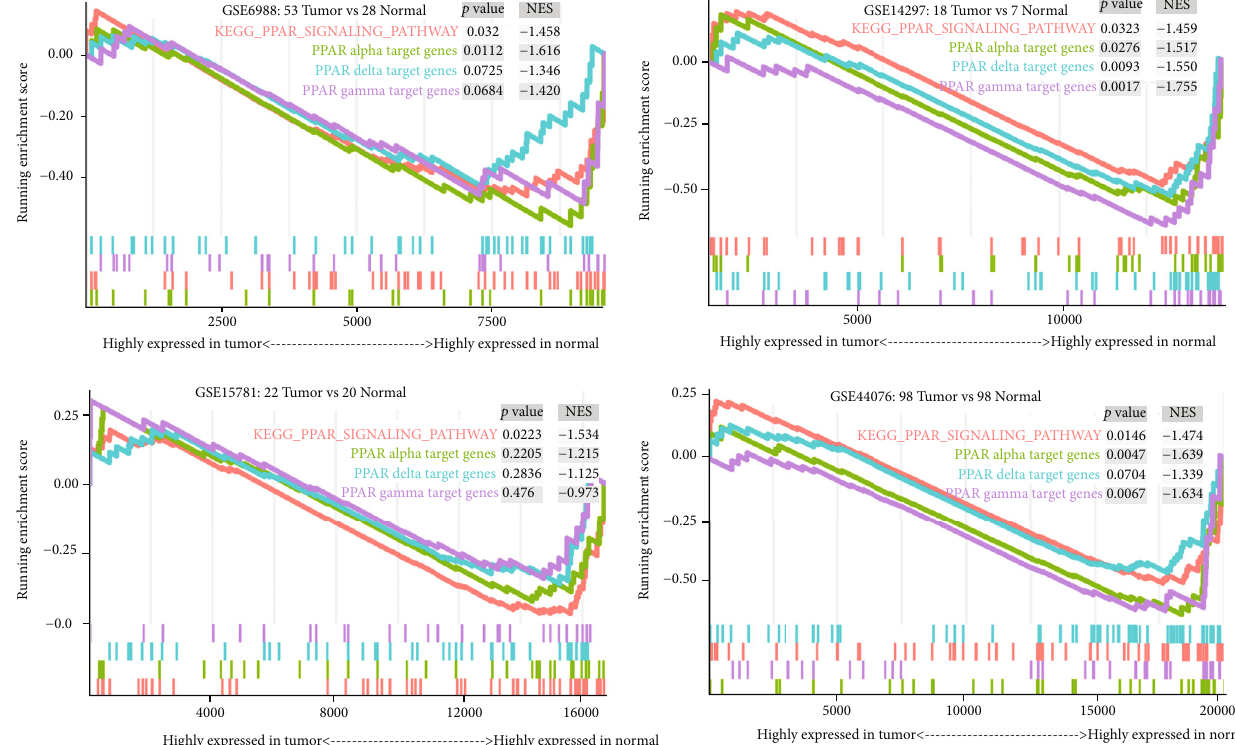
Figure 1: GSEA analyzes the di ff erence in expression levels between colon cancer and normal controls. Four gene sets related to expression levels from four GEO cohorts were analyzed. The curve above the enrichment score of 0 points shows that the gene set is activated in colon cancer. A curve below 0 point shows that it is more active in the normal controls than in colon cancer. P adjust: adjusted P value; NES: normalized enrichment